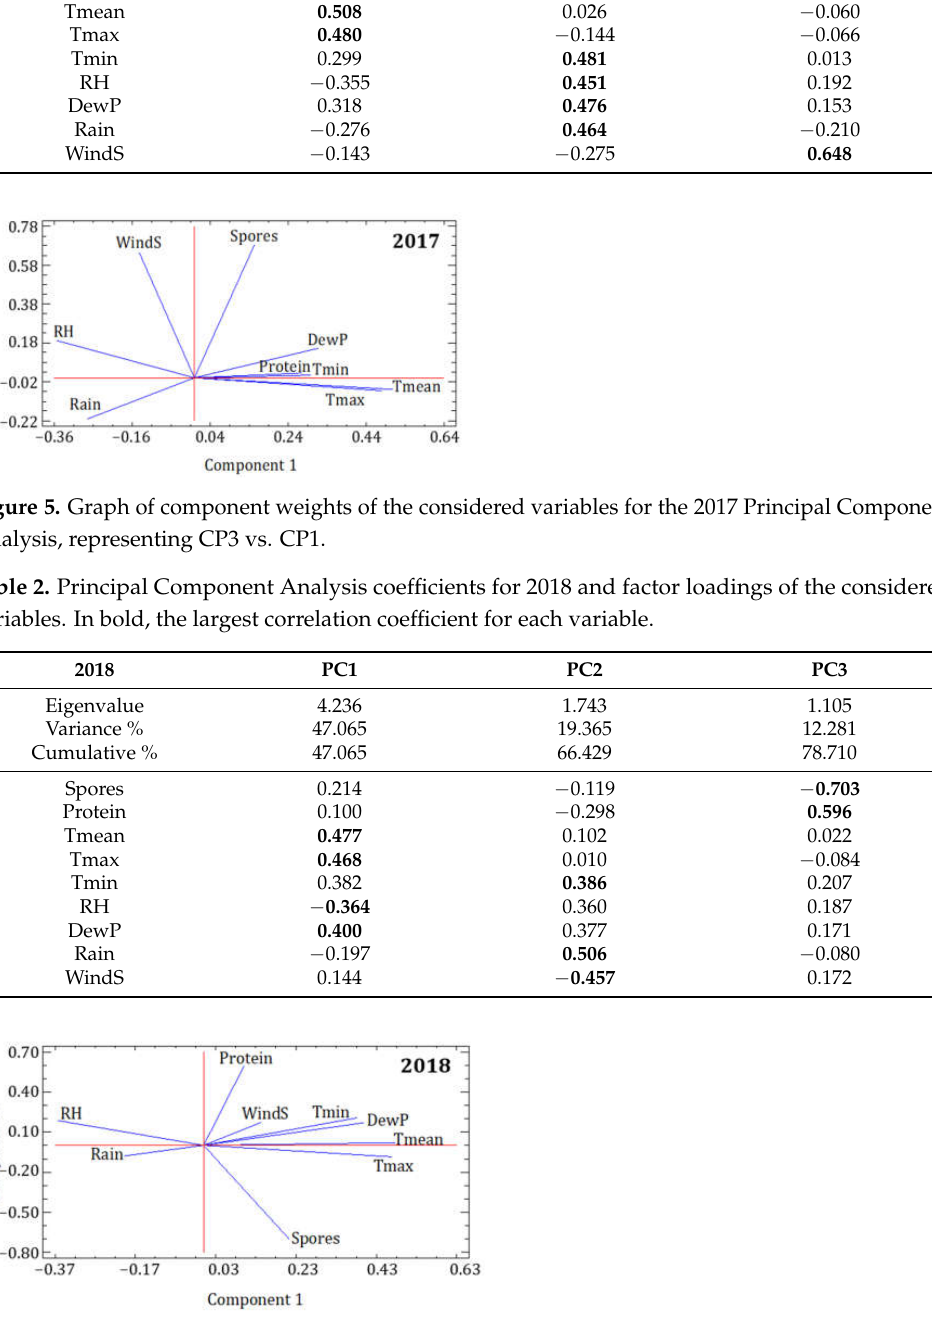
Figure 6. Graph of component weights of the considered variables for the 2018 Principal Component Analysis, representing CP3 vs. CP1.